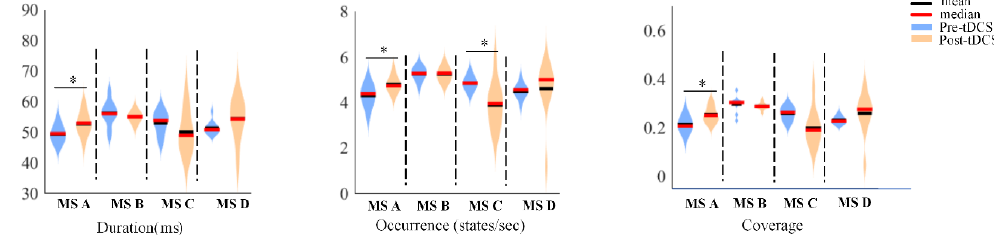
Figure 5. The differences in the three temporal parameters of the four microstates before tDCS and after tDCS for the experimental group. * denotes p < 0.05. Table 1. The scores of the ABC scale in the experimental group before and after